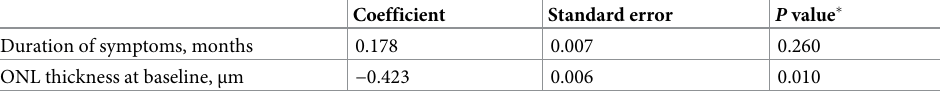
Table 5. Baseline factors related to M-CHARTS score at 12 months after reduced-fluence photodynamic therapy. Coefficient Standard error P value � Duration of symptoms, months 0.178 0.007 0.260 ONL thickness at baseline, μ m − 0.423 0.006 0.010 ONL, outer nuclear layer. � Multiple regression